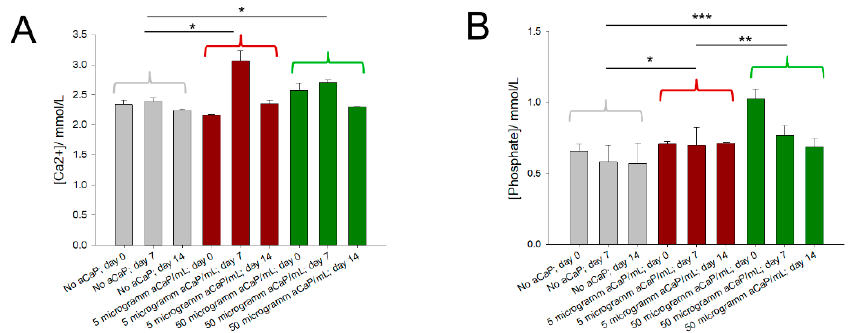
Figure 3. Average free calcium concentrations ( A ) and phosphate concentrations ( B ) for three con- ditions and two three points, with 0, 5, or 50 µg/mL aCaP nanoparticles and initially, as well as 7 or 14 days in culture, respectively. Two-way ANOVA for Ca 2+ revealed significant differences between day 0 and day 7 ( p = 0.0003), day 7 and day 14 ( p = 0.0001), 0 and 5 µg/mL aCaP ( p = 0.0113, marked with *), as well as 0 and 50 µg/mL aCaP ( p = 0.0132, marked with *). Two-way ANOVA for phosphate revealed significant differences between day 0 and day 7 ( p = 0.0323), day 0 and day 14 ( p = 0.0027), 0 and 5 µg/mL aCaP ( p = 0.0300, marked with *), 0 and 50 µg/mL aCaP ( p < 0.0001, marked with ***), as well as 5 and 50 µg/mL aCaP ( p = 0.0100, marked with **). Error bars indicate standard deviations. Table 4. Ionic activity products ( Qs0 ) and differences between logQs0-logKs0 for nine different conditions (numbered 1– 9), i.e., no aCaP, 5, or 50 µg/mL aCaP and time points 0, 7, and 14 days, respectively, calculated based on measured free calcium and phosphate ion concentrations (see Figure 2). No corrections regarding ionic strength were made.